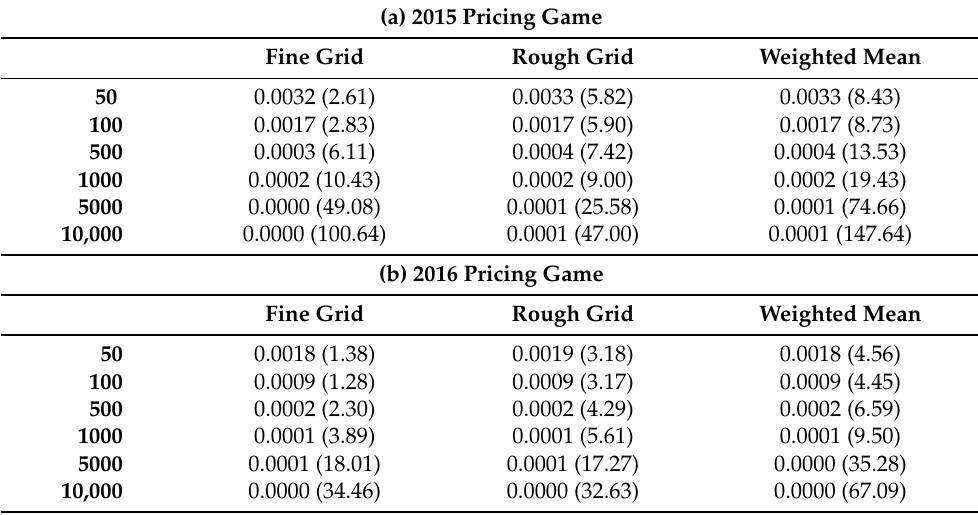
Table 4. Bias and run time (s), the latter between brackets, for the original marginal approximation of ( 0.05 ) on the 2015 and 2016 pricing game dataset. This is given for the fine grid, rough grid and C ≈ 0,1 + weighted-mean-plot approach, all for several different numbers of boundary values.